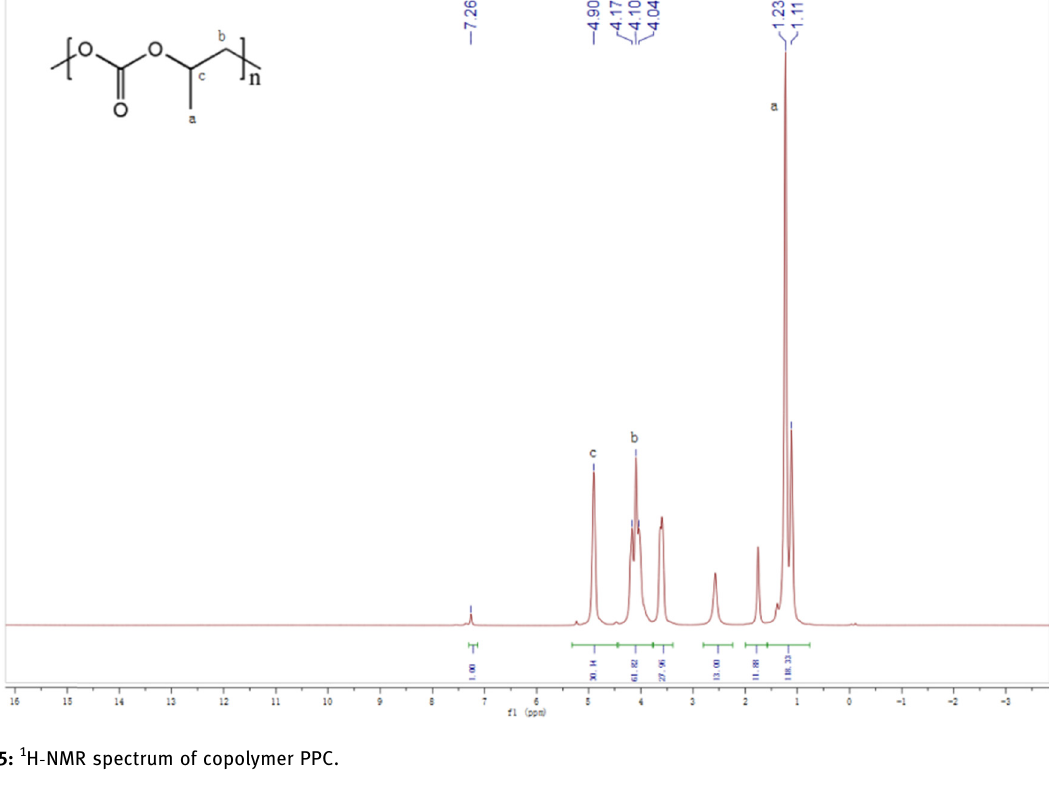
Figure A5: 1 H - NMR spectrum of copolymer